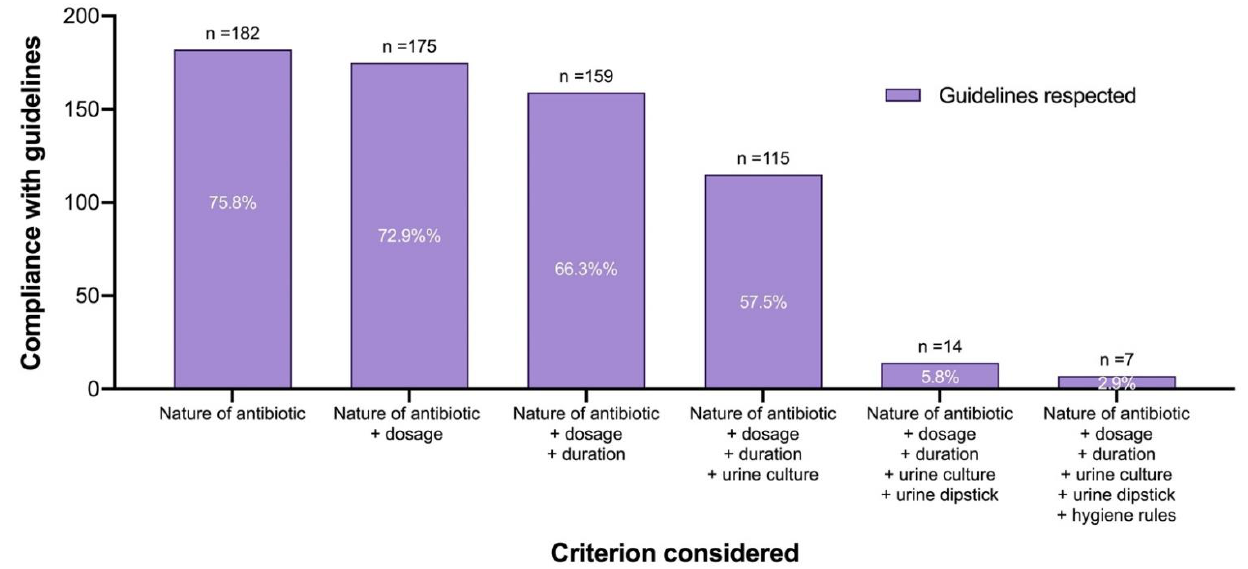
Figure 4. The compliance of uncomplicated cystitis management with recommendations using cumulative criteria (n = 240). Each column represented a new compliance criterion. The starting point was the compliance of the nature of the antibiotic, then its dosage, and its duration. Then, the compliance of the urine examination, urine culture, and urine dipstick were added. Finally, the explanation of hygiene rules was included.